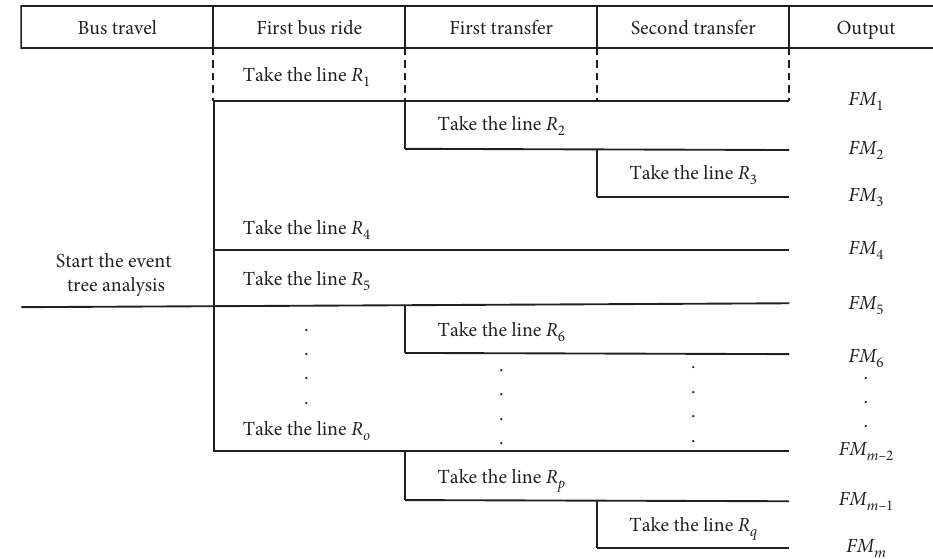
Figure 2: The structure of the event tree based on bus trips.